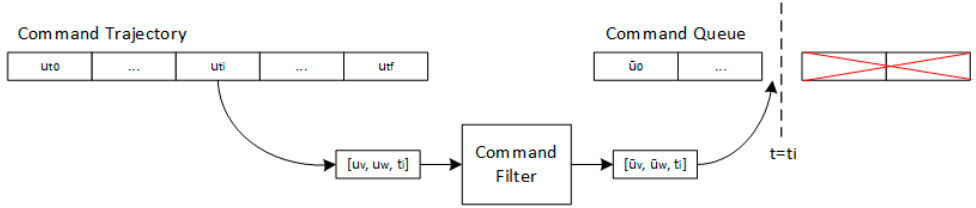
Figure 11. Command management process of the command executor node.